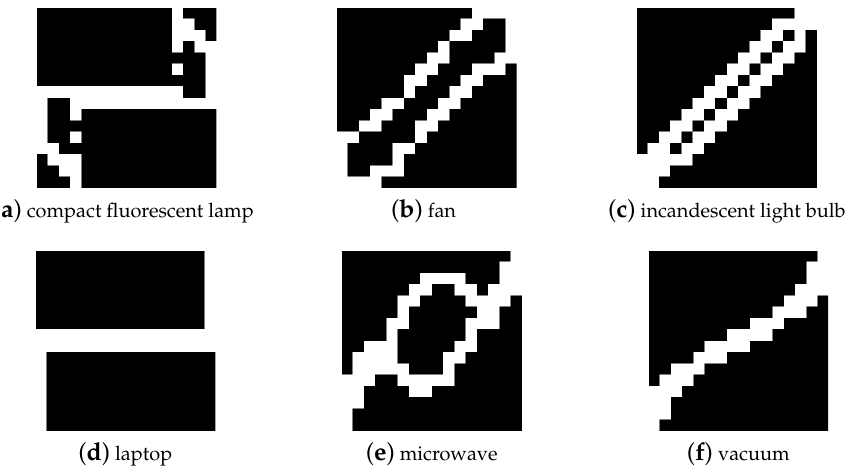
Figure 4. Binary V-I trajectories for six different appliances from PLAID